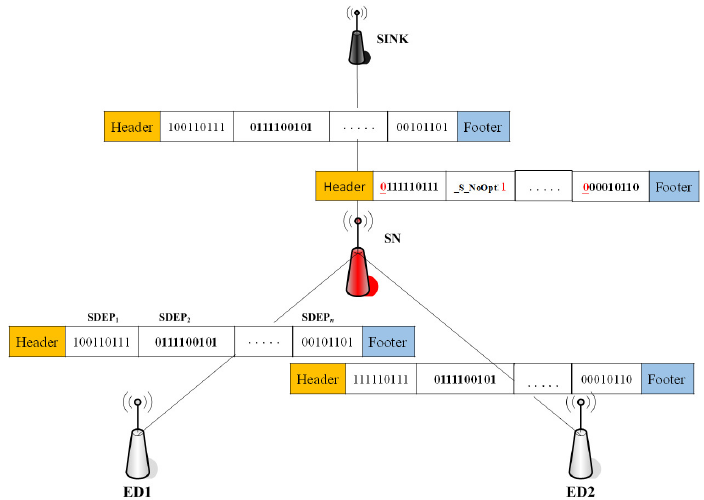
Figure 5. Spatial correlation encoding for sensor packets from 2 neighboring EDs.